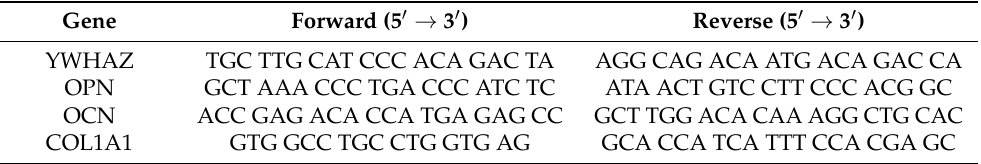
Table 1. qPCR primer pairs. tyrosine 3-monooxygenase/tryptophan 5-monooxygenase activation protein zeta (YWHAZ; reference gene), secreted phosphoprotein 1/osteopontin (SPP1/OPN), osteo- calcin (OCN), type I collagen alpha 1